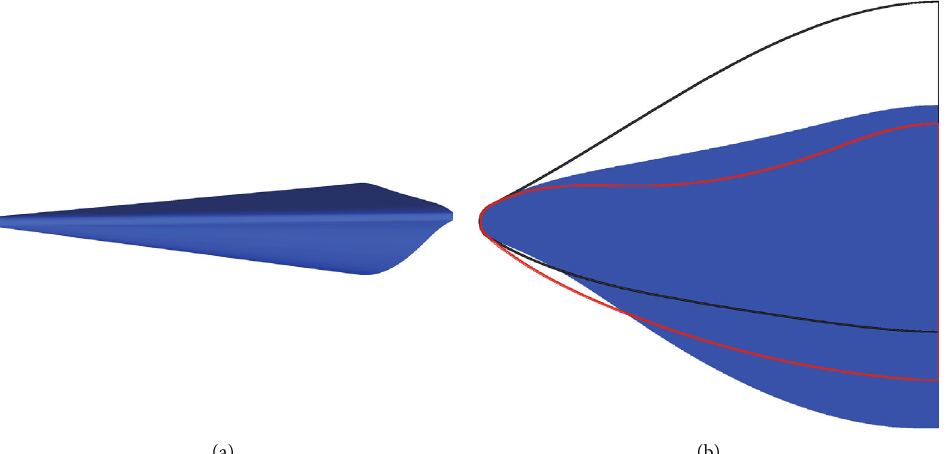
Figure 9: The optimum: (a) con fi guration and (b) after-body section compared with the baseline (black line) and the typical con fi guration (red